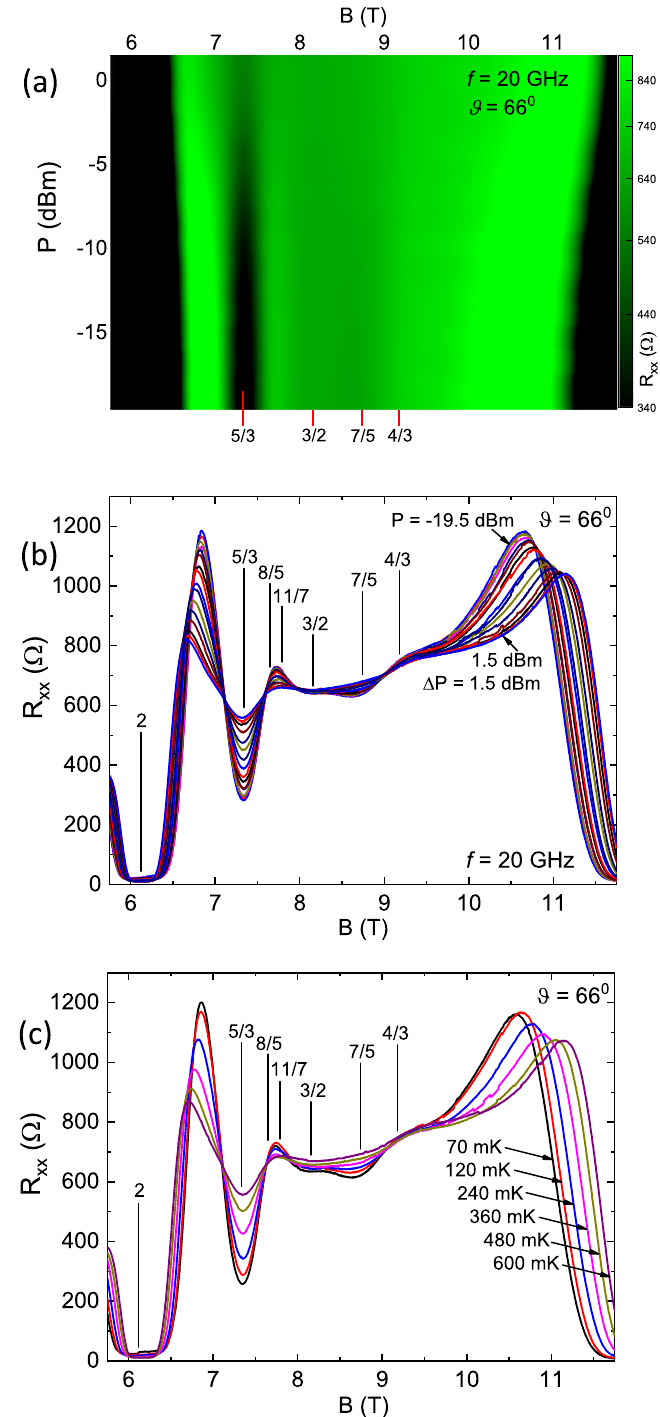
Figure 6. Microwave power ( a , b ) and temperature ( c ) evolution of the diagonal resistance R xx between 5.75 ≤ B ≤ 11.75 T at a tilt angle θ = 66 0 . (a) Color plot of R = 20 GHz . P is specified in xx vs. B and vs. P at f dBm (decibel - milliwatts) (b) R xx vs. B is plotted at various microwave power P between − 19.5 ≤ P ≤ 1.5 dBm in steps (cid:31) P = 1.5 dBm . Some filling factors of interest are marked with vertical lines. (c) R xx vs. B is plotted at temperatures 70 ≤ T ≤ 600 mK . Some filling factors of interest are marked with vertical lines. Note the absence of a resistance minimum or maximum, or temperature sensitivity, at ν = 4 / 3 in all three